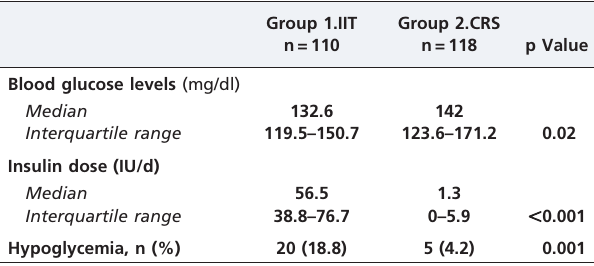
Table 2 - Insulin therapy and blood glucose levels.